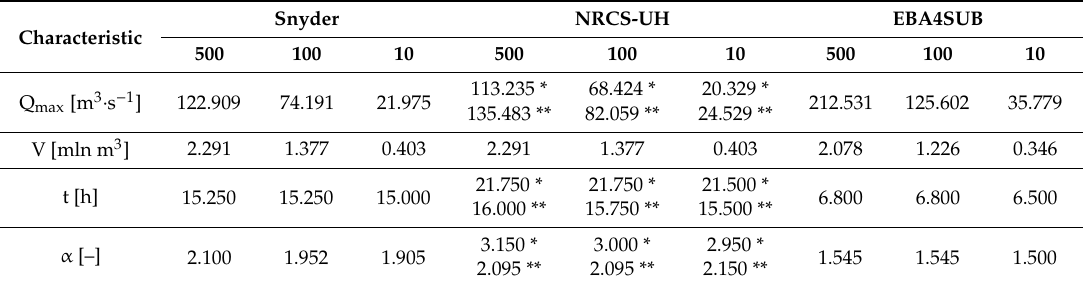
Table 3. Characteristics of design hydrographs determined using the analyzed models.